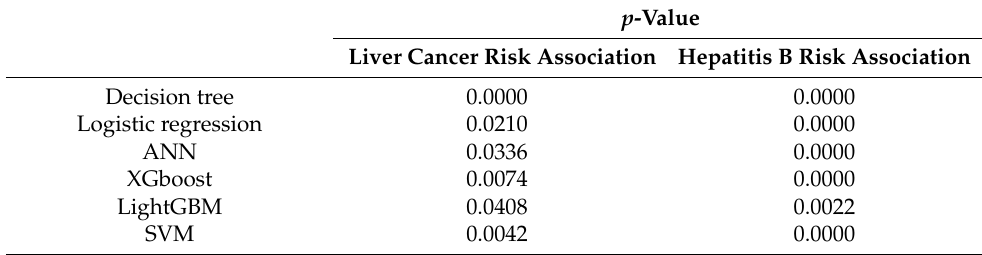
Table 7. Results of Wilcoxon signed-rank test between random forest and comparative models.